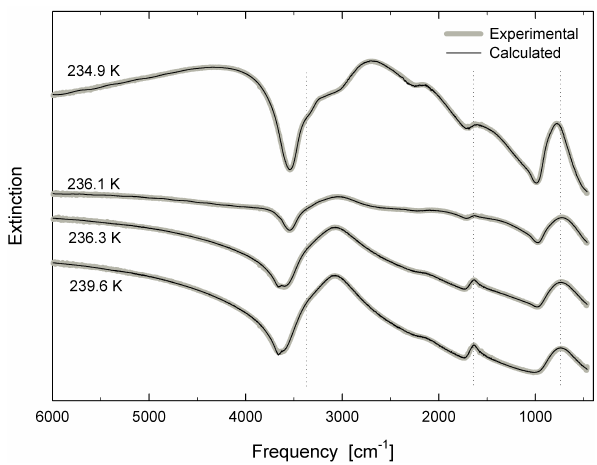
Fig. 3. Experimental extinction spectra obtained from freezing ex- periments using medium droplets generated by atomization at dif- ferent candidate freezing temperatures. The spectra calculated from the retrieved size distributions are overlaid in